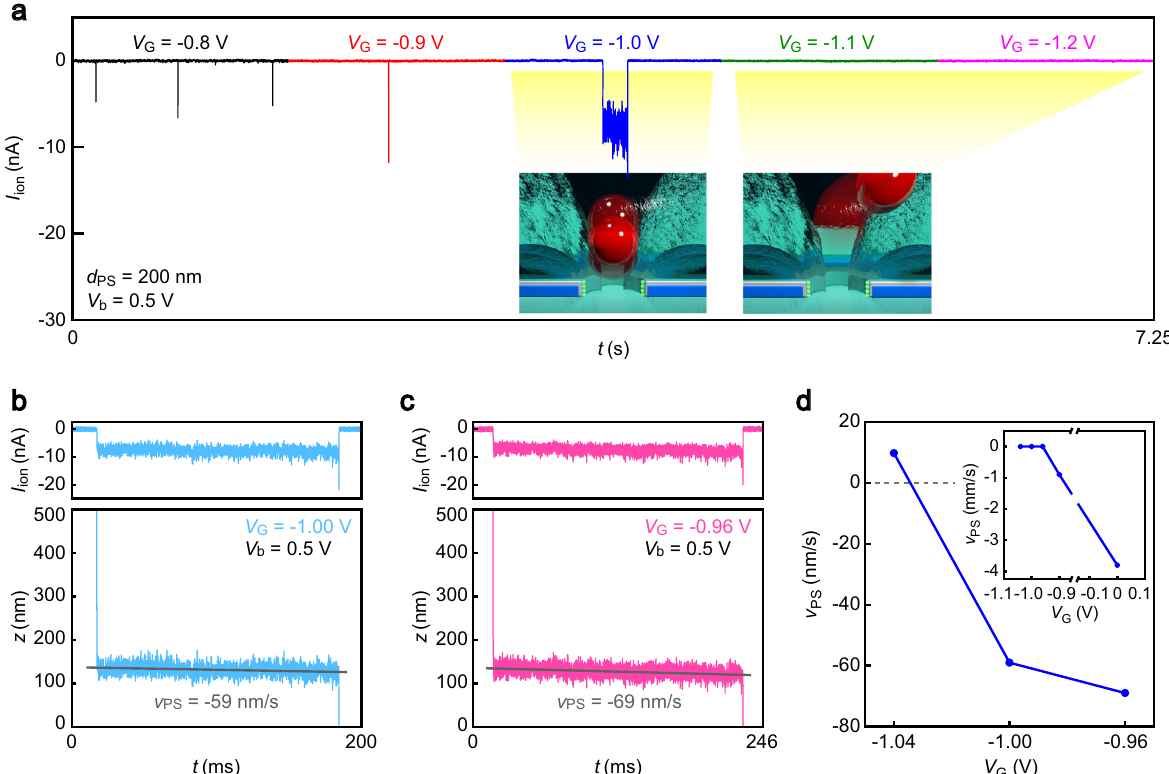
Fig. 6 Gate-controlled single-nanoparticle motions. a The effective range of V G for the particle trap. The ionic current signals (top) and the corresponding z – t characteristics for 200 nm-sized nanoparticles captured under V slope signify the average velocity v ps of the nanoparticles. d V G -dependence of v PS